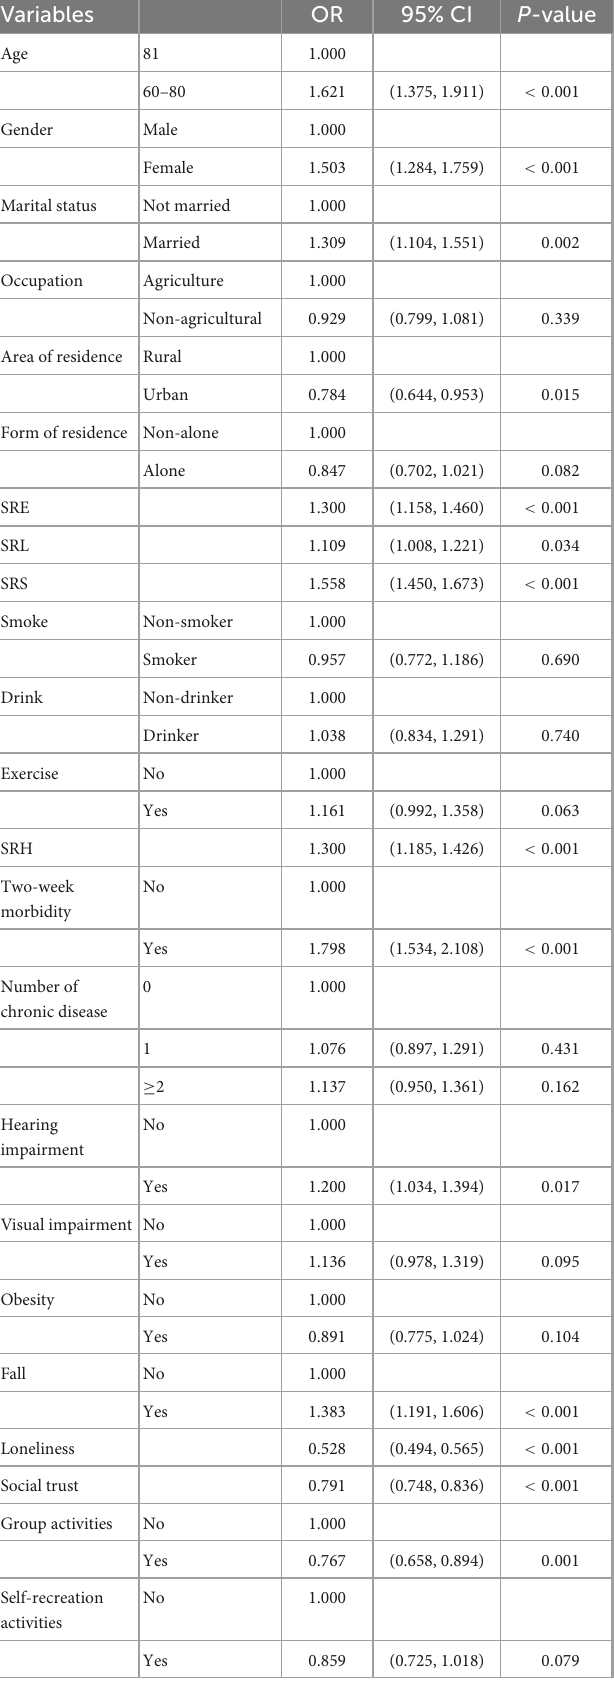
TABLE 2 Binary logistic regression analysis of anxiety in the